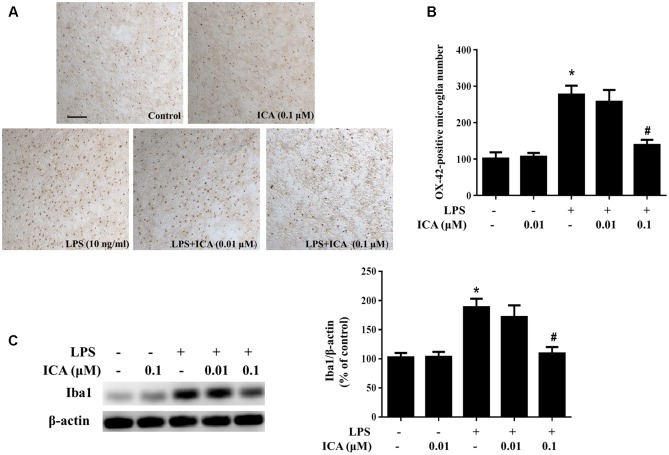
Icariin ameliorated LPS-induced microglial activation in vitro. Rat primary midbrain neuron-glia cultures were treated with ICA (0.01 and 0.1 μM) for 30 min and then stimulated by LPS (10 ng/ml). Seven days later, the activated microglia were detected by immunocytochemical staining with anti-OX-42 antibody. Representative images of immunostaining from three experiments were indicated (A). Scale bar: 100 μm. The quantification of OX-42-positive microglia was performed (B). The level of Iba1 protein expression in the neuron-glia co-cultures was detected via western blot assay (C). The ratio of densitometry values of Iba1 with β-actin was assessed and normalized to each respective control group. Results were the mean ± SEM from three independent experiments performed in triplicate. ∗p < 0.05 compared with the control cultures; #p < 0.05 compared with LPS-treated cultures.